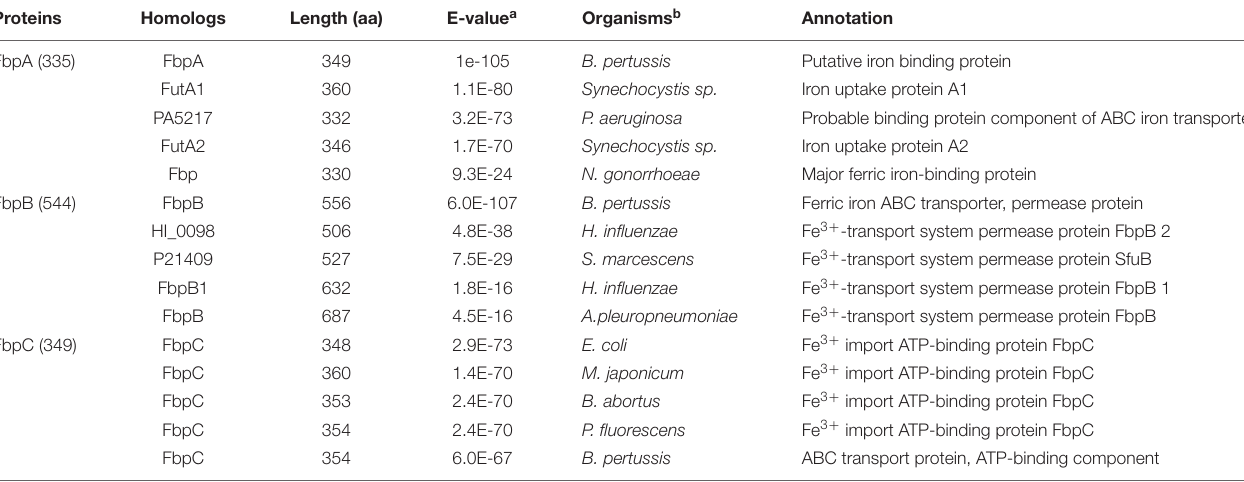
TABLE 2 | Top five homologs of S. oneidensis FbpABC in other bacteria. Proteins Homologs Length (aa) E-value a Organisms b